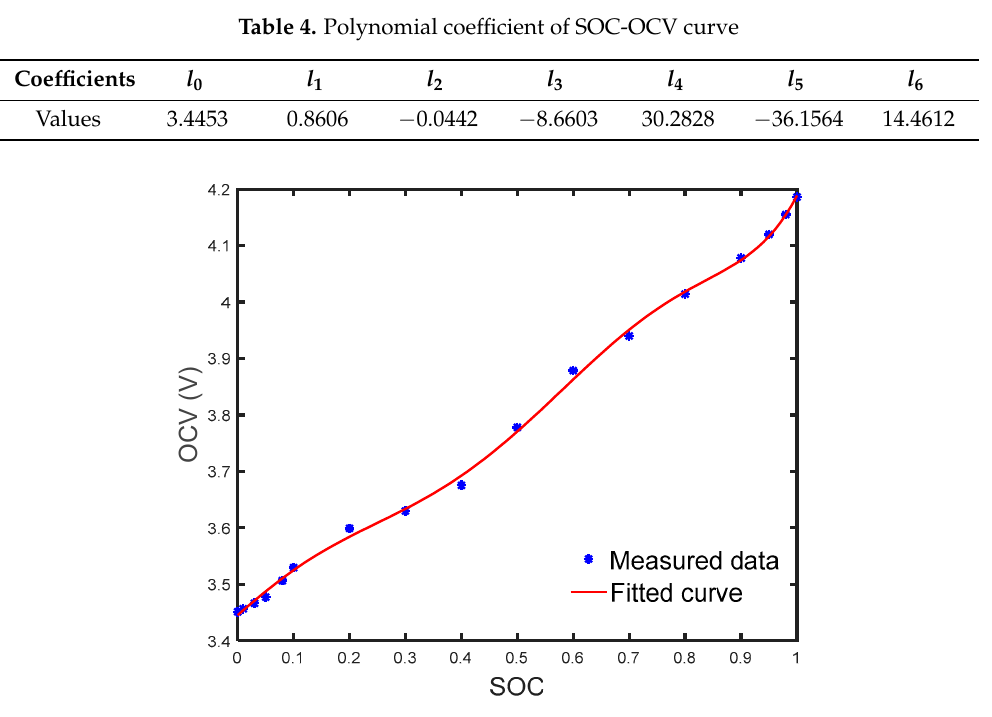
Figure 4. The measured data and fitted curve of OCV and SOC. Table 4. Polynomial coefficient of SOC-OCV curve